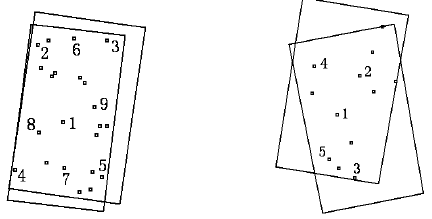
Fig4. the distribution of same Fig5. the distribution of opposite side-looking direction stereo side-looking direction stereo images and ground points images and ground points Ground known points available through triangulation encryption methods by optical SPOT5 HRS and HRG images with Integration Mapping Software PixelGrid (Zhang, 2009), and the precision higher than the accuracy of 1:50 000 topographic